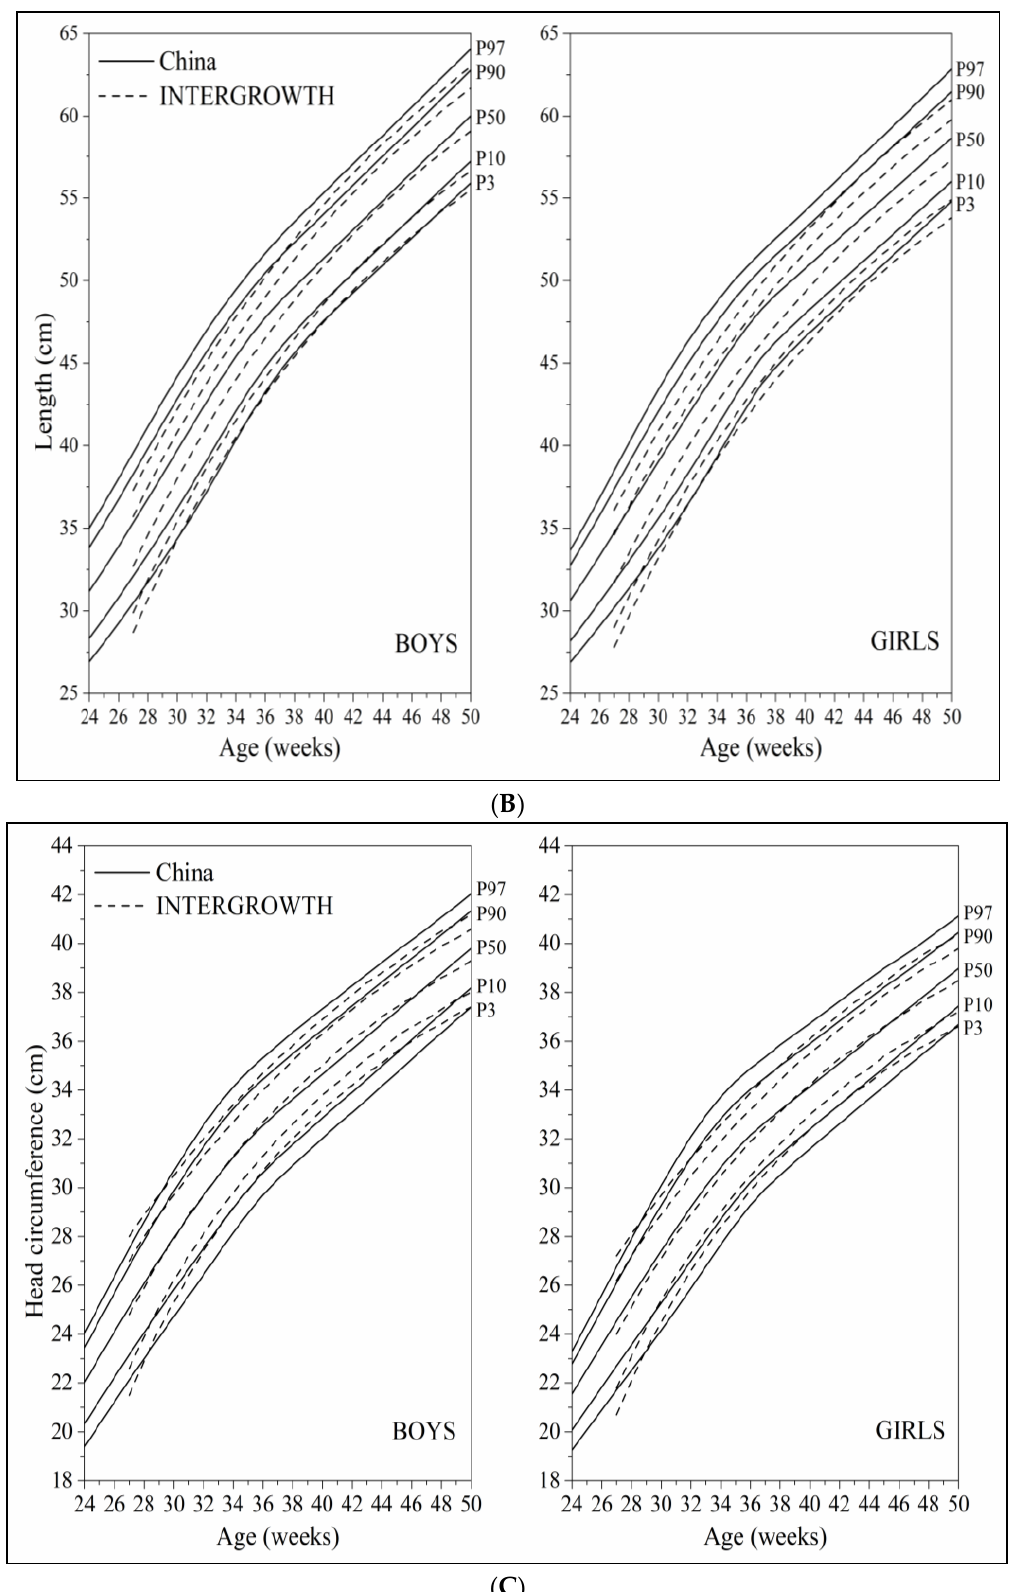
Figure 5. Comparison of the 3rd, 10th, 50th, 90th, 97th percentile curves between the China curves and the INTERGROWTH curves; ( A ) weight; ( B ) length; ( C ) head circumference.